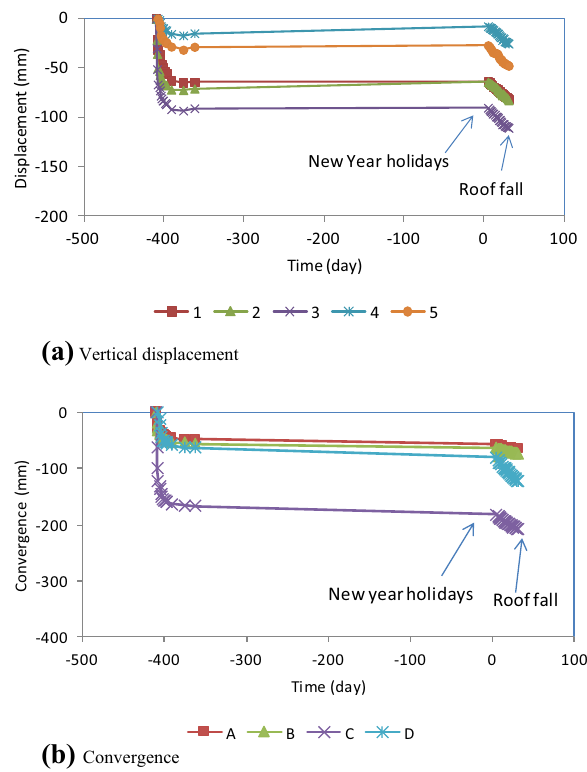
Fig. 5 Monitored deformation at the section B (296.5 m behind the face and the edge at the entrance side of 24 the roof fall). Negative values indicate a downward and b contraction. Time is set to zero at the discovery 25 of the damage (Jan. 6,